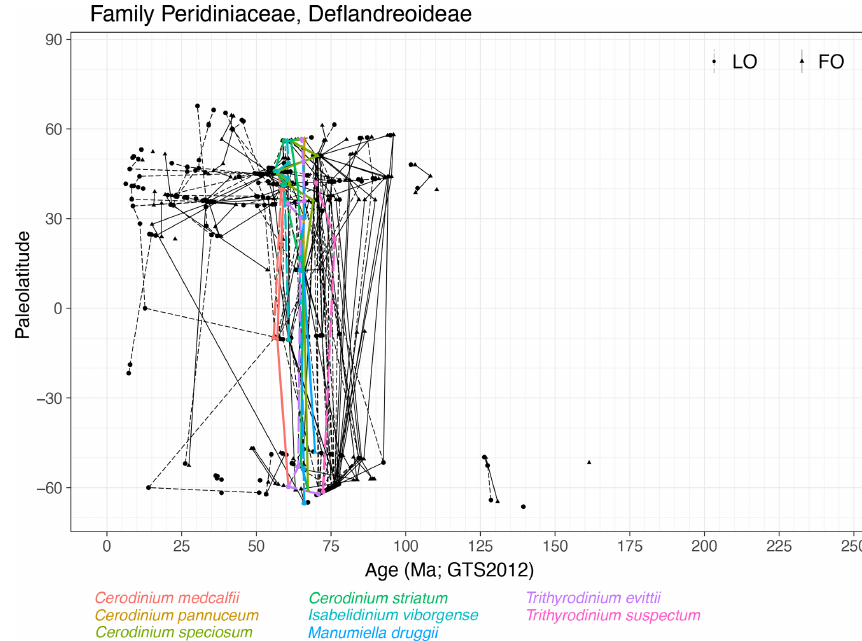
Figure 21. Same as Fig. 5 but for the family Peridiniaceae, subfamily Deflandreoideae.